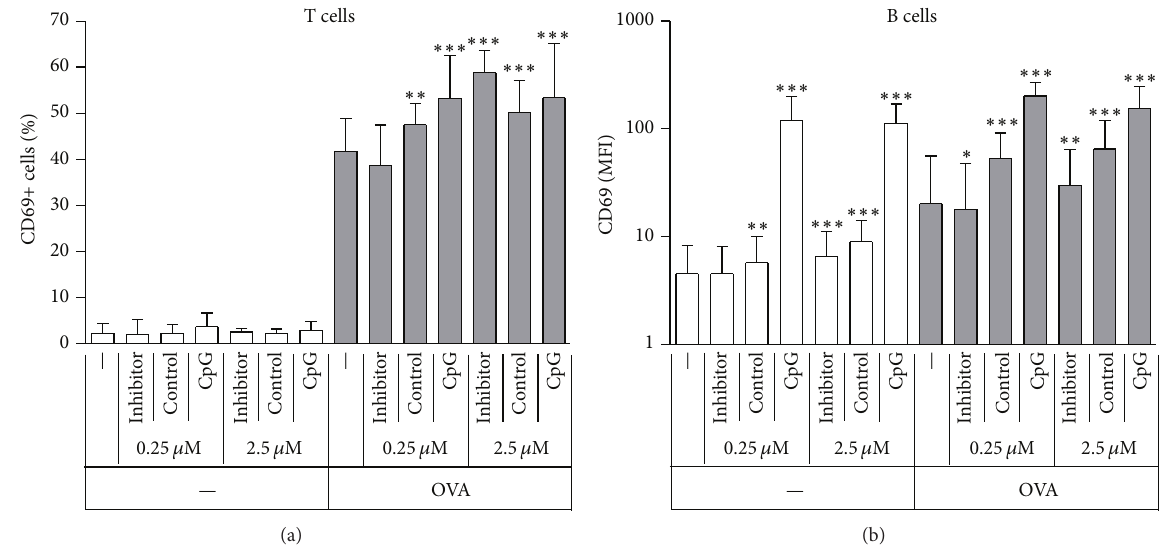
Figure 1: Non-CpG ODN enhances CD69 expression in T and B cells engaging in cognate interaction. DO11.10 splenocytes were incubated with different combinations of ODNs and OVA; after 24 hours CD69 expression was measured on T and B cell populations by flow cytometry ((a)-(b)). Medians and interquartile ranges of 13 independent experiments are shown. Asterisks indicate significant difference from the group receiving no ODN at all, within the respective OVA treatment group. MFI: mean fluorescence intensity; ∗ 𝑃 < 0.05 ; ∗∗ 𝑃 < 0.01 ; ∗∗∗ 𝑃 < 0.001 .